Question: What visual encoding does this figure use to show its data?
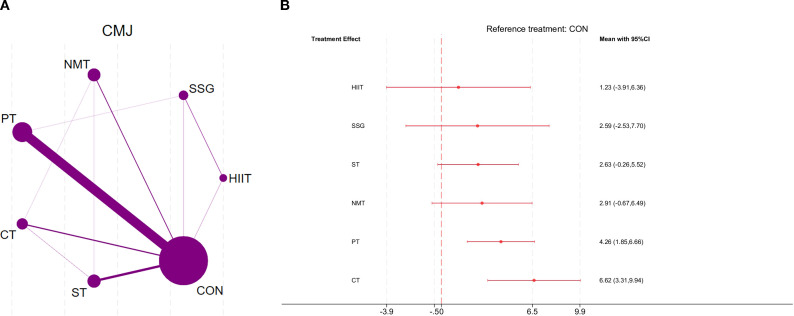
Answer: forest